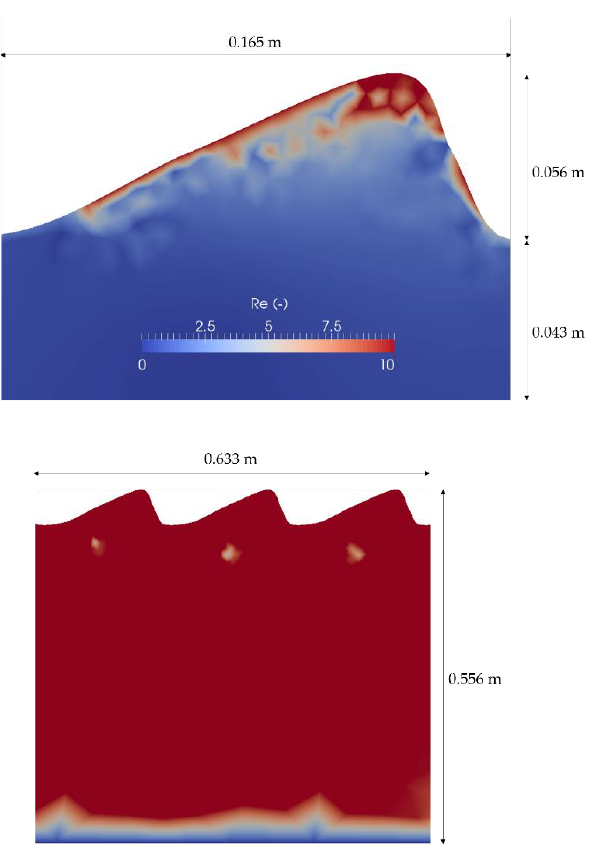
Figure 7. Reynolds numbers at a sandy ( top ) and gravel ( bottom ) ripple for case 1 (Table 1).